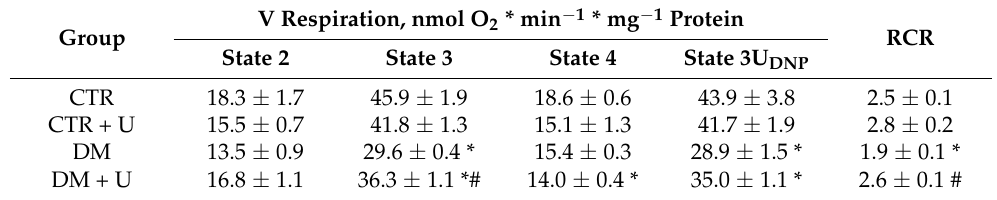
Table 2. Parameters of respiration and oxidative phosphorylation of mouse heart mitochondria in the experimental groups.